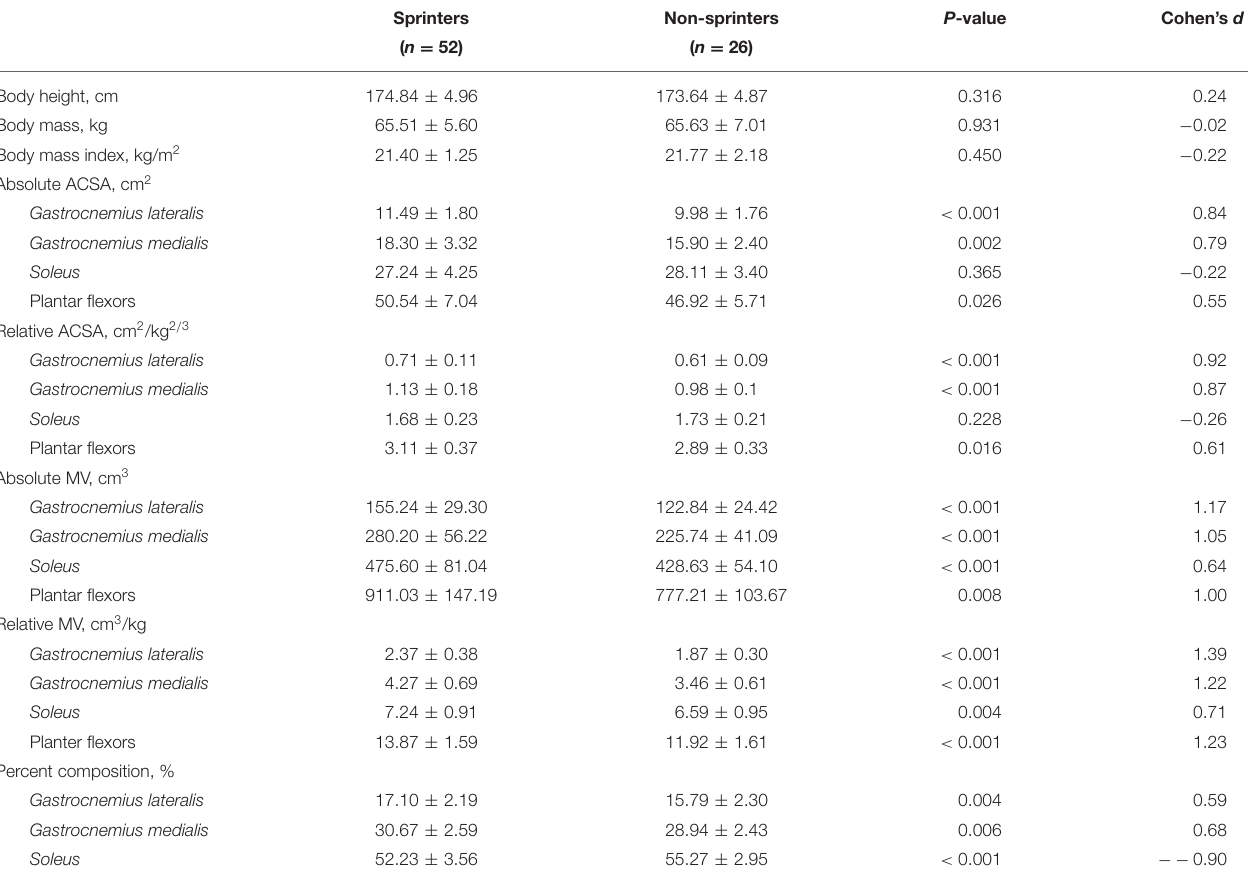
TABLE 1 | Physical characteristics and plantar flexor muscle size variables in sprinters and